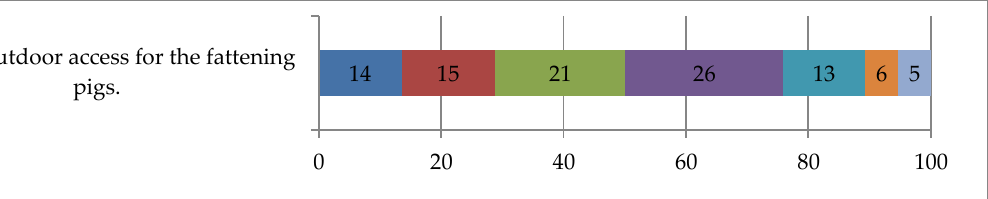
Figure 2. Frequency distribution of the statement ″ There is outdoor access for the fattening pigs ″ .